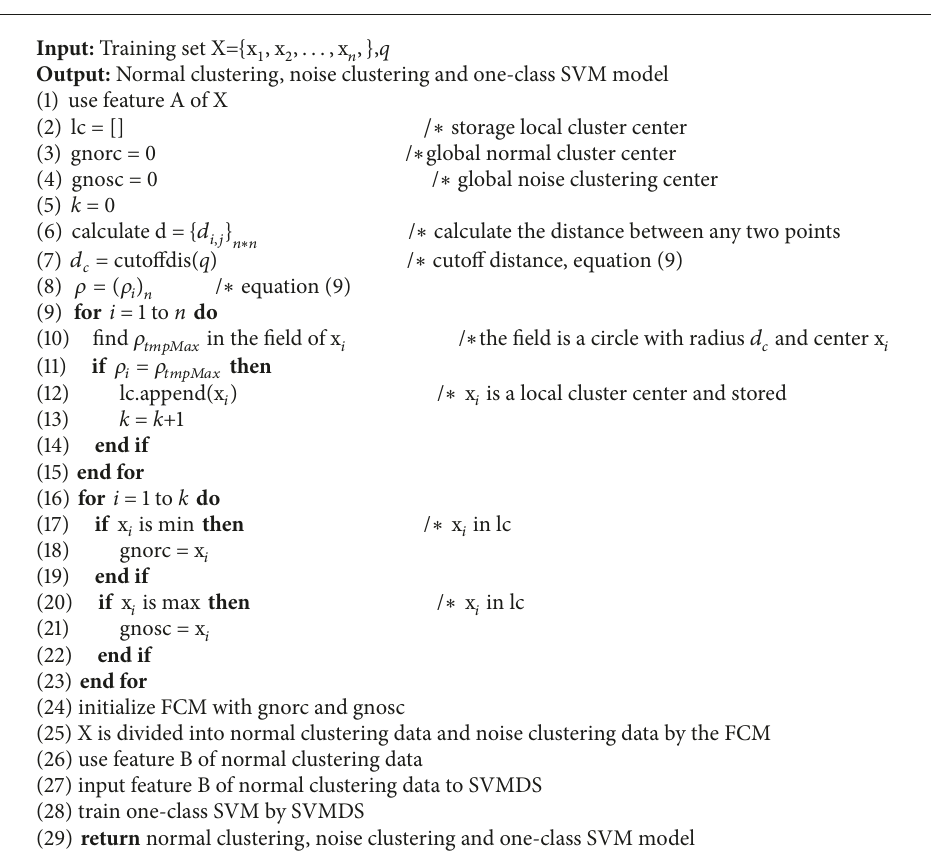
Algorithm 1: T r aining Stage .